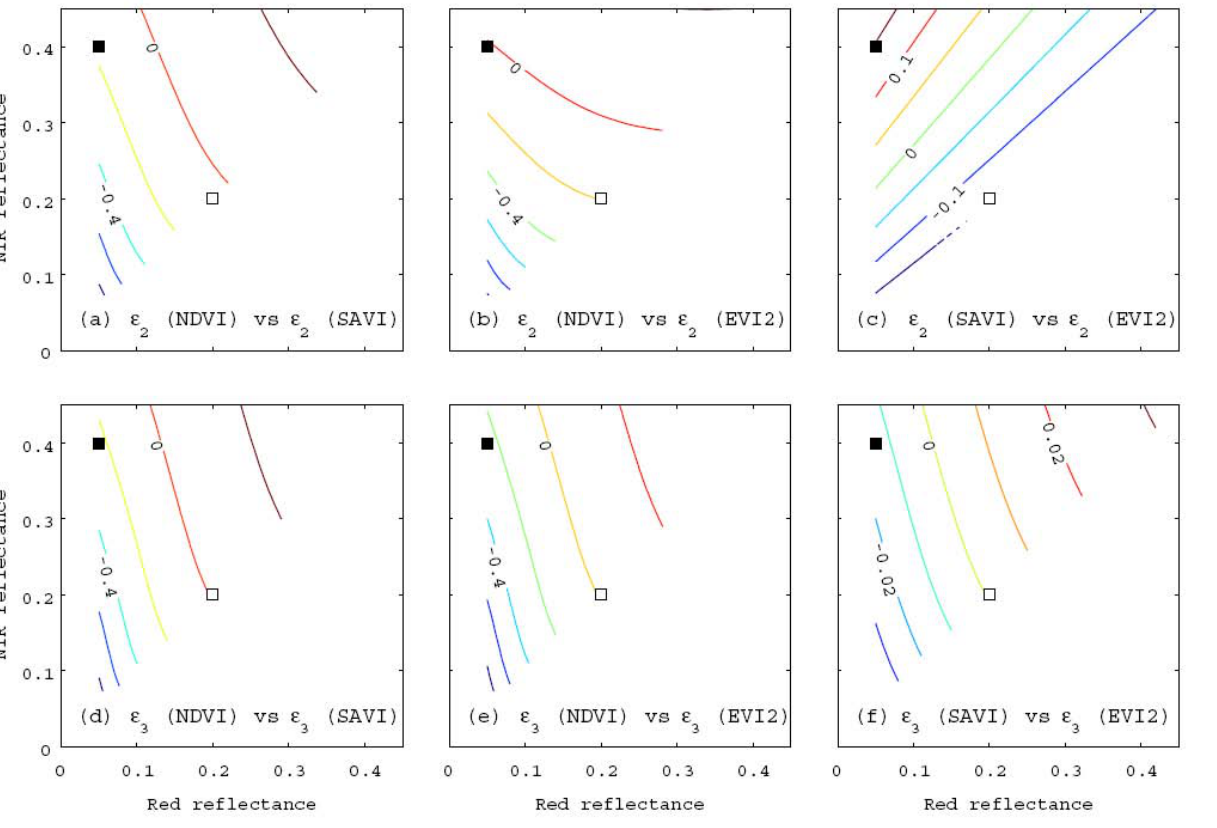
Figure 11. Results of numerical simulations describing the distribution of tan θ on a 0 log scale over the red-NIR reflectance spectrum. Algorithm-2 or -3 were compared using different VI conditions (comparison of the intra-algorithm relationship) and with EM1 as the endmember spectra. The results indicate the influences on the target spectrum and the choice of VI on tan θ . ( a – c ) show the tan θ -map for algorithm-2 using NDVI and SAVI, 0 0 NDVI and EVI2, and SAVI and EVI2 as the endmember models. ( d – f ) show tan θ -map for 0 algorithm-3 using the same sets of VI used in the upper three panels as